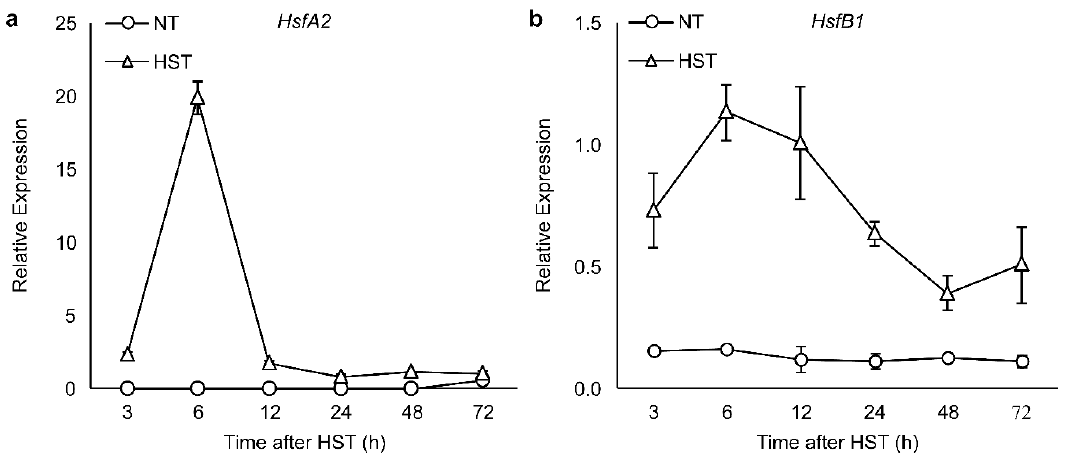
Figure 4. Changes in the relative expression level of ( a ) HsfA2 and ( b ) HsfB1 . Gene expression levels in the first leaf at 3, 6, 12, 24, 48, or 72 h after HST (45 °C, 2 min) were quantified by qPCR and normalized to GAPDH expression. Vertical bars indicate the standard error of the mean ( n = 4).